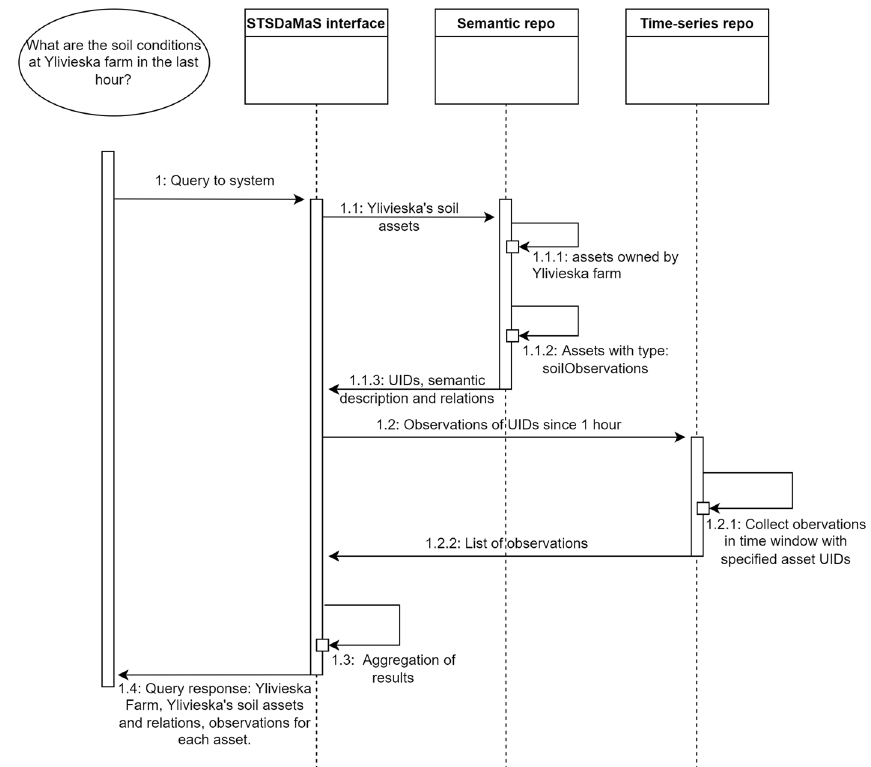
Fig. 3 High‑level query processing by